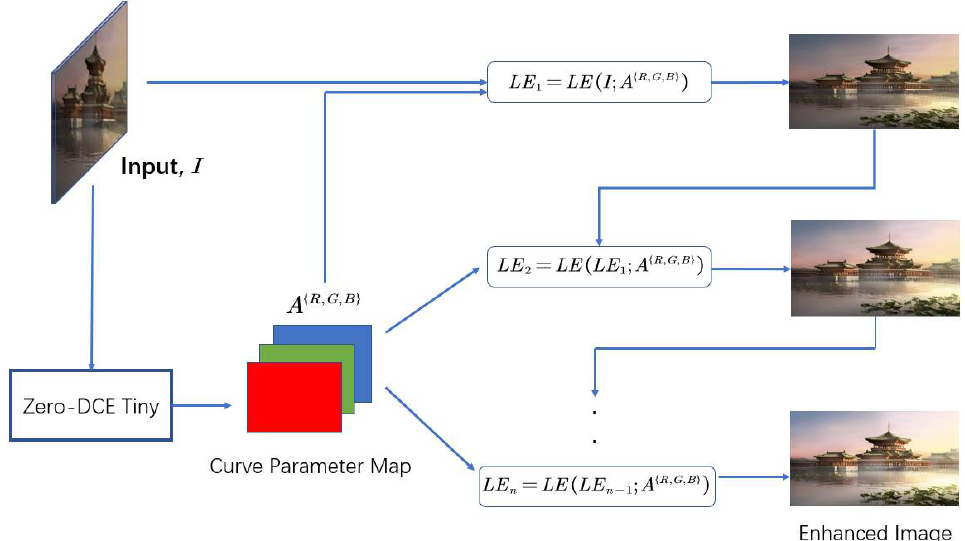
Figure 1. Overall structure diagram.